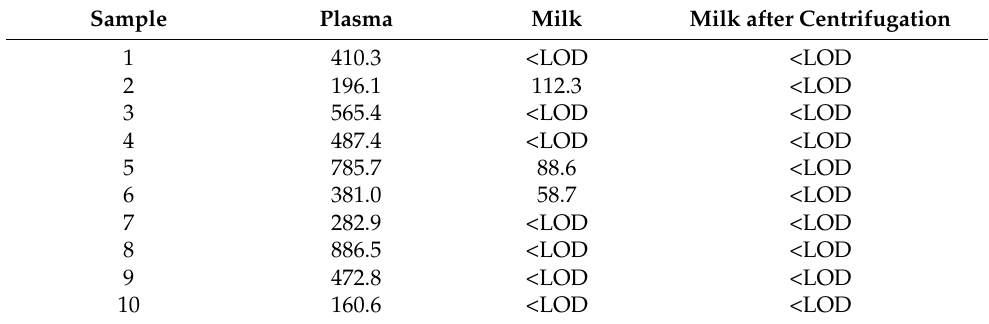
Table 2. PCT concentrations (pg/mL) in sick cows measured with bovine PCT ELISA kit. Legend: LOD—limit of